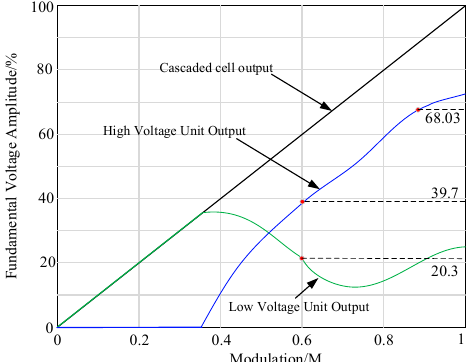
Figure 7. Unipolar LS-PWM modulation strategy schematic diagram (Reference [17]).